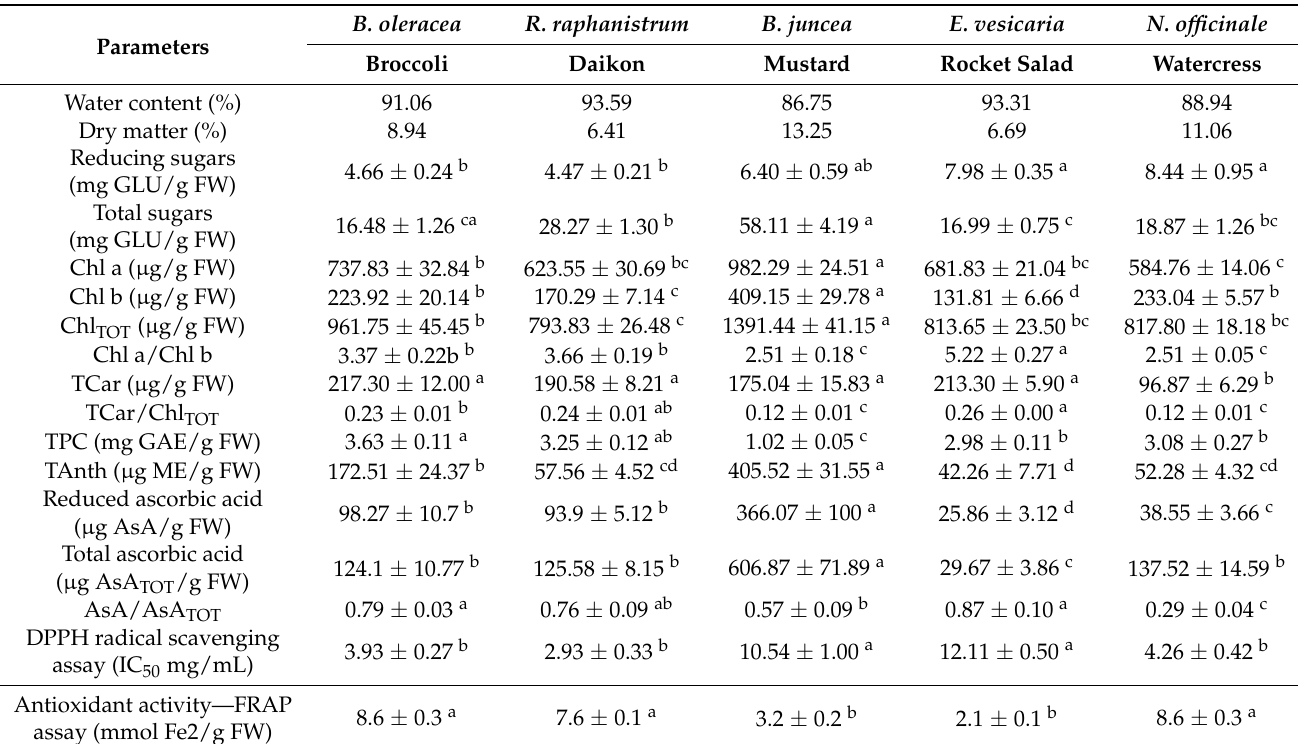
Table 1. Biochemical data for all of the evaluated parameters in the analyzed Brassicaceae species.